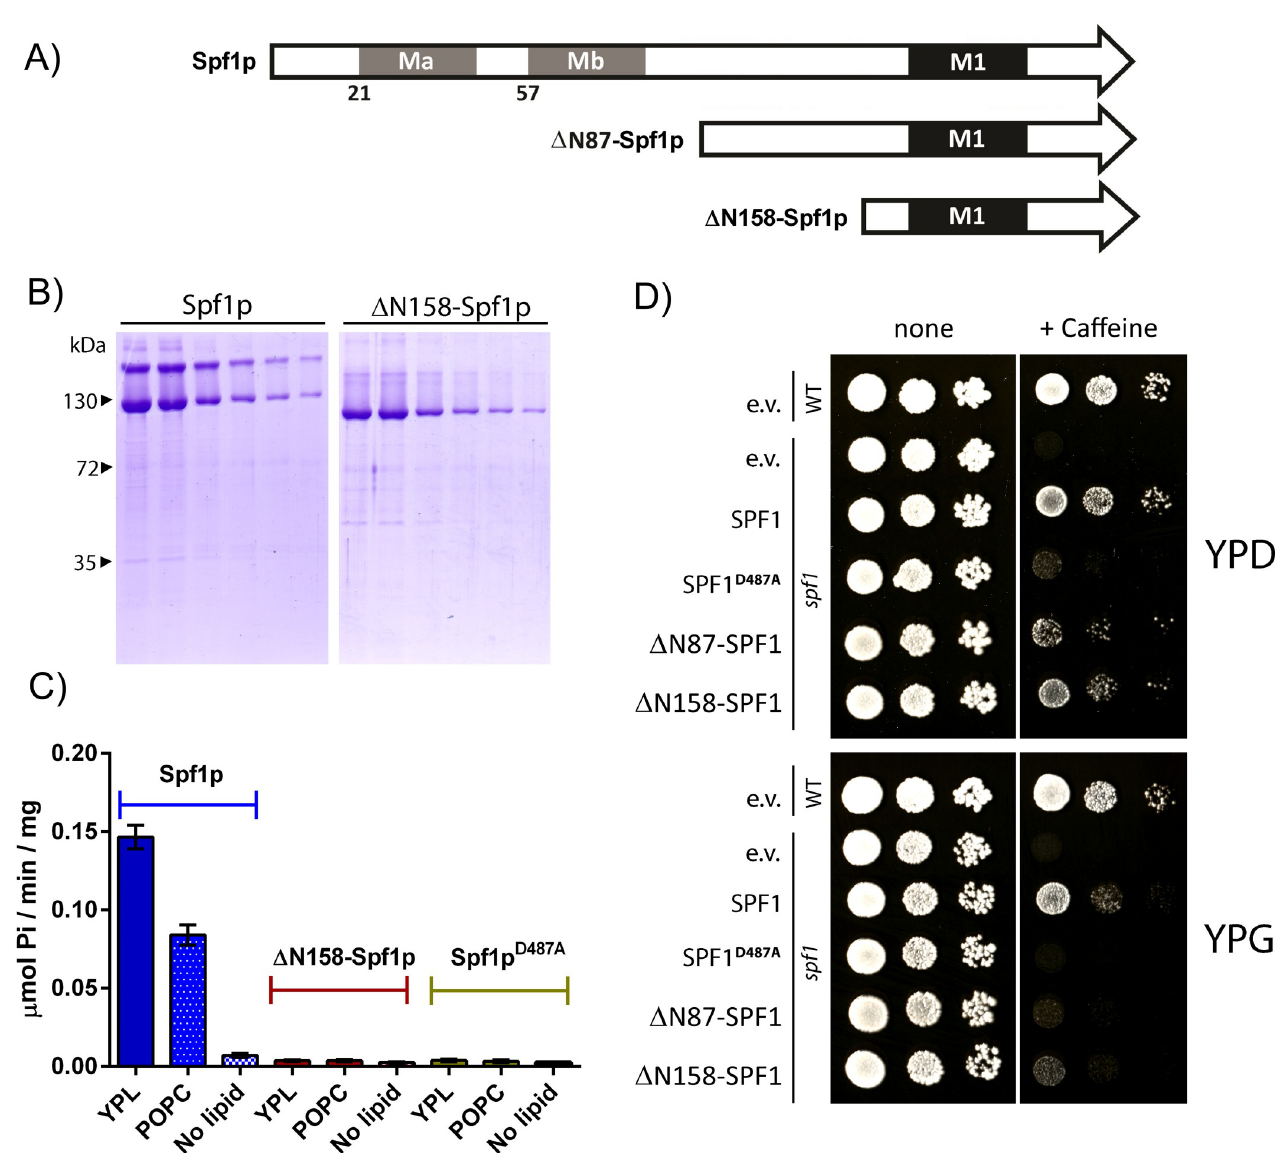
Fig 4. Viability of Spf1p and N-terminally truncated Spf1p. A) Schematic overview of N-terminal truncations performed by genetically removing the genetic sequence that codes for the first 87 and 157 amino acids of the expression construct. Ma, Mb and TM1 is indicated in accordance with [3, 20]. B) SDS-PAGE showing the eluates for the purified fractions of the full-length expression construct (Spf1p) and the N-terminally truncated expression construct ( Δ N187-Spf1p). C) ATPase activity measured for full-length (Spf1p), N-terminally truncated expression construct ( Δ N187-Spf1p) and a dead control (Spf1p- D487A) after re-lipidation in mixed lipid/detergent micelles using OG as detergent (YPL, POPC) or with no lipids added. D) Complementation in spf1 deletant cells using the same expression constructs. The catalytic dead mutation D487A and the empty vector is used as a control. Complementation was tested on 10 mM caffeine plates as described in [12]. Plates grown on glucose (YPD) repression of the promotor allows survival of cells expressing the N-terminally truncated version of SPF1, but high expression conditions on galactose (YPG) hinders